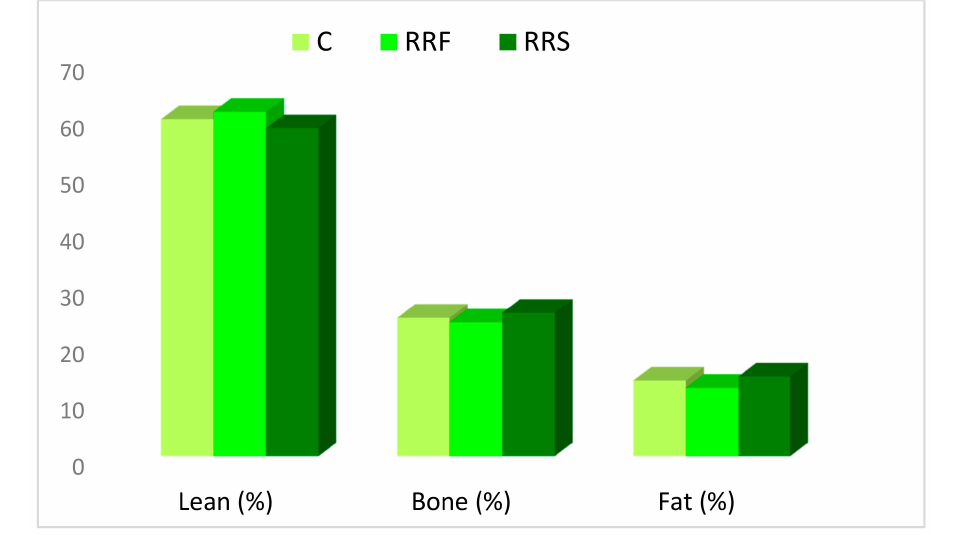
Figure 2. Carcass tissular proportion of Barbarine lambs fed RR-based